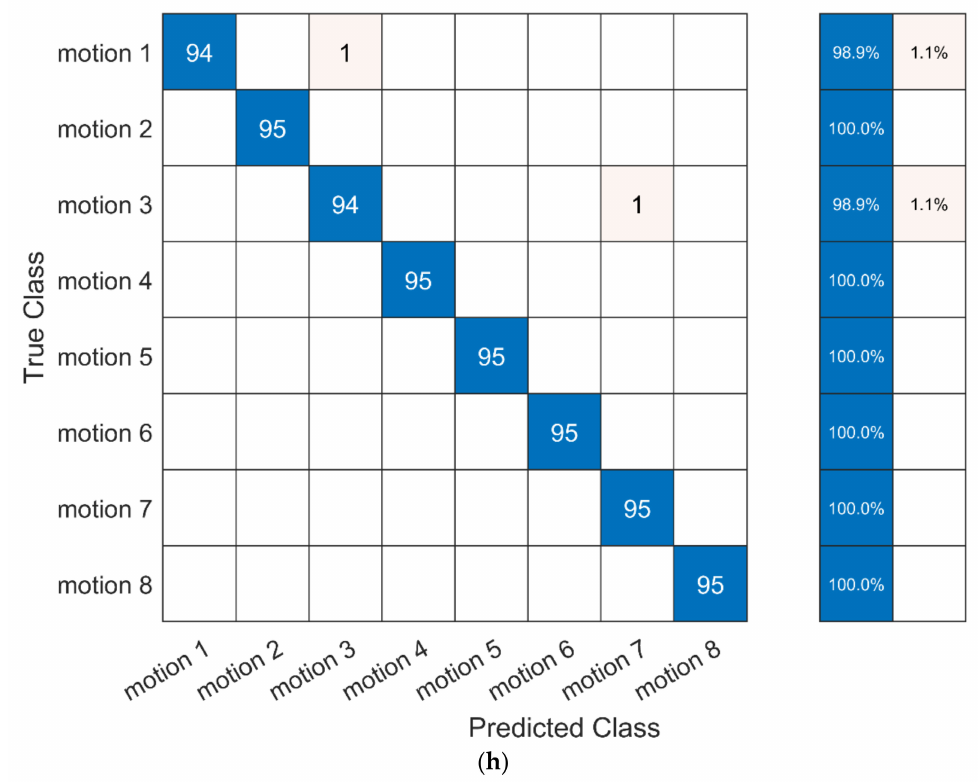
Figure 10. The confusion matrices of motion recognition on different classifiers: ( a ) k -NN, ( b ) SVM,